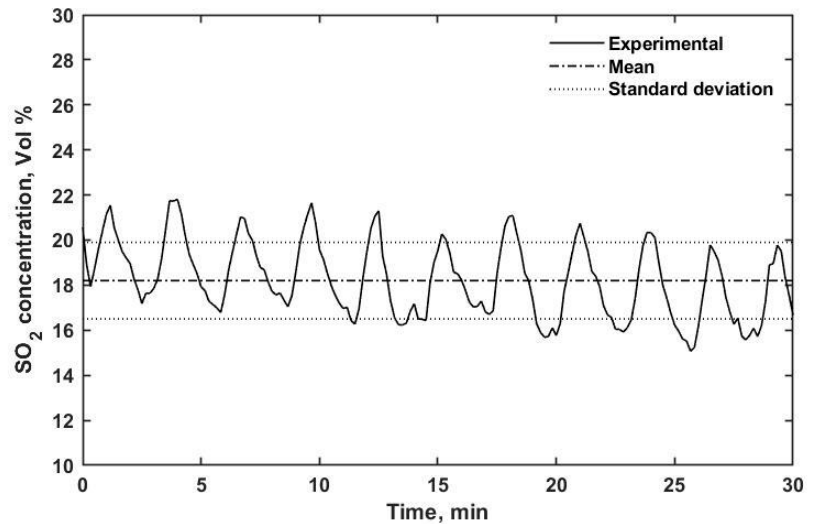
Figure 6. Evolution of the SO 2(g) concentration in the gases generated during the conversion of molten white metal, conducted with the 0.006 m × 0.004 m injector, placed 0.05 m from the surface of the melt at 1533 K. Table 5. Oxygen consumption rate and efficiency for molten white metal conversion experiments.